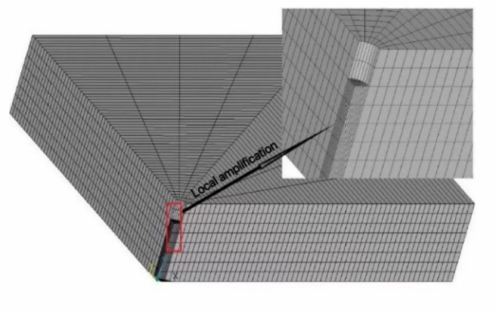
Figure 3. Gridding.